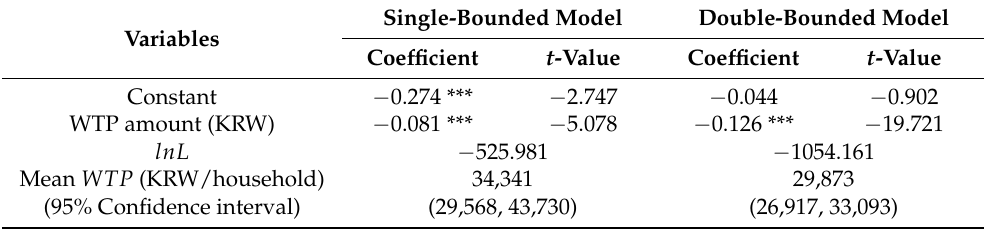
(Table 2). The respondents’ average WTP from the single-bounded model was KRW 34,341 with a 95% confidence interval (CI) of KRW 29,568 and KRW 43,730. The respondents’ average WTP from the double-bounded model was KRW 29,873 with a 95% CI of KRW 26,917 and KRW 33,093. The estimated WTP of the double-bounded model is more refined than that of the single-bounded model as expected. Table 2. Estimates of WTP for addressing malodor issue without explanatory variables.